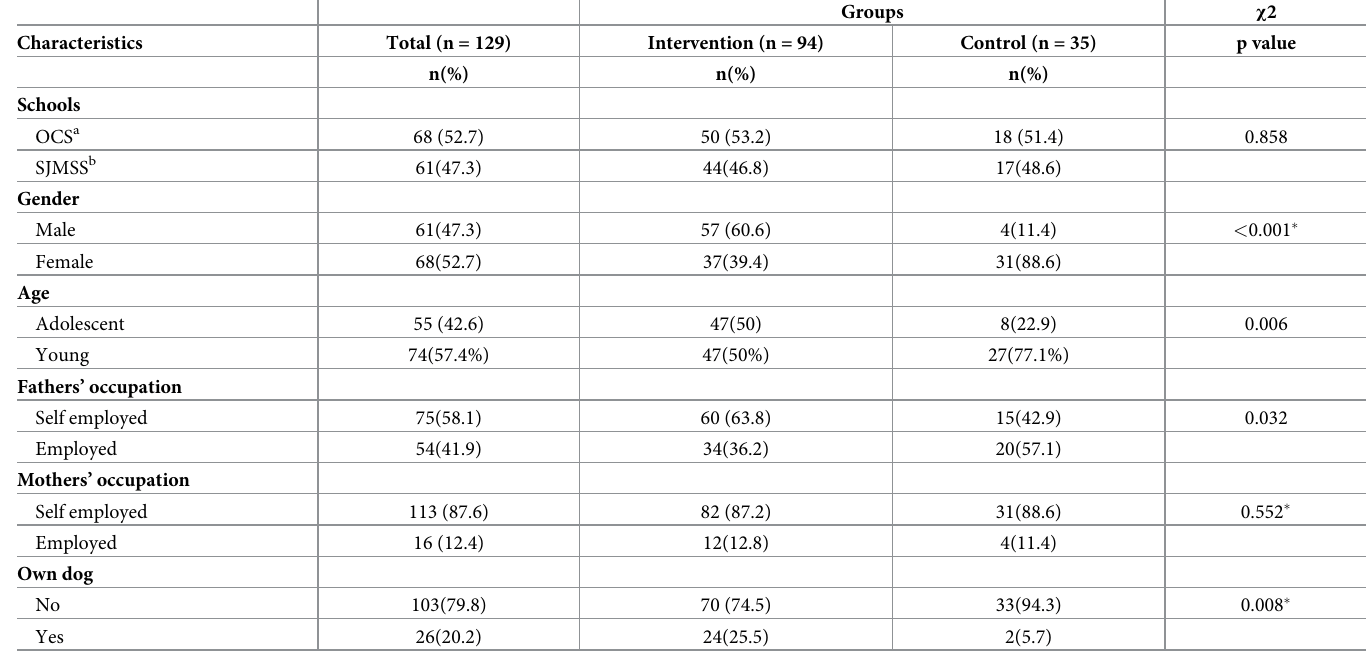
Table 1. Socio-demographic characteristics of the students who participated in the rabies education interventional study from two schools in Samdrup Jongkhar District, South eastern Bhutan (n =